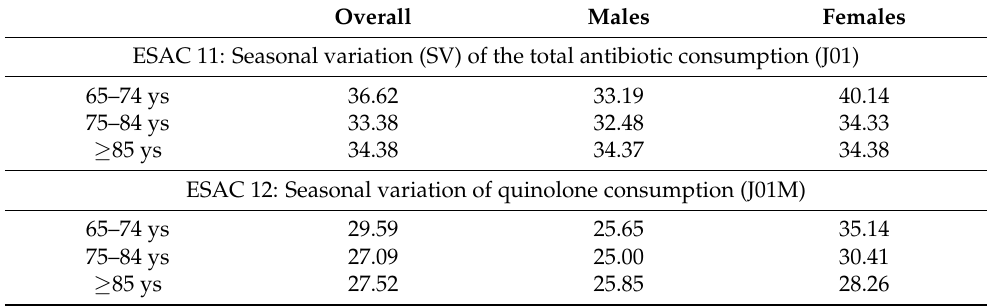
Table 3. Cont. Overall Males Females ESAC 11: Seasonal variation (SV) of the total antibiotic consumption